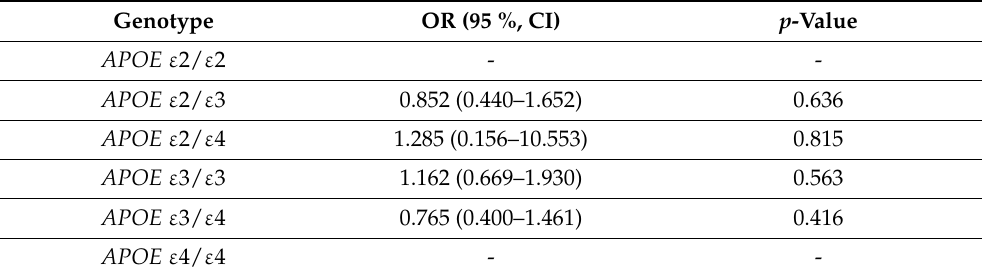
Table 3. APOE binary logistic regression in patients with ON and control groups.